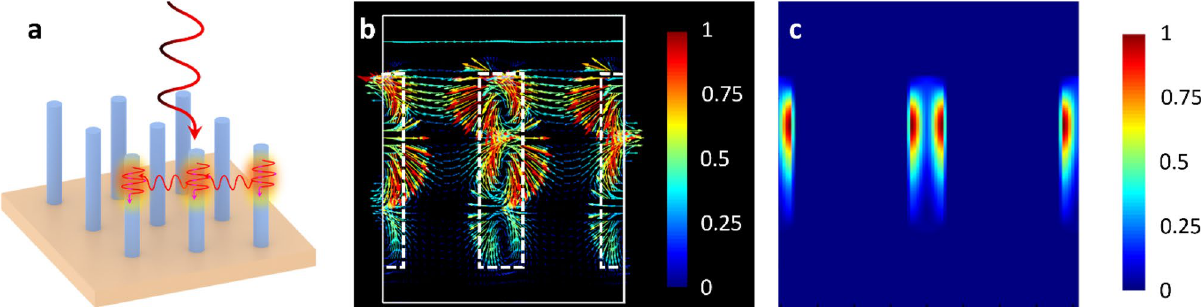
Figure 1. Mechanisms for enhanced absorption. ( a ) Schematic view of the collective interaction of a cylindrical nanowire metamaterial depicting the direct and indirect coupling to leaky guided and transverse modes. The leaky nature of the guided modes in the nanowires leads to free-space scattering of the electric field, which is then recoupled into the neighbouring nanowire metaatoms via excitation of TE and TM modes. ( b ) Simulated electric field response of a nanowire array with periodicity of 833 nm, nanowire diameter of 200 nm and height of 1400 nm. The interaction of the electric field between neighbouring nanowires is depicted by the vectors and their color indicates the field strength. ( c ) Localized absorption profile (indicated by the color) of the nanowire metamaterial at λ = 1020 nm with the same dimensions as ( b ). In the ( b , c ) color bars, red represents the maximum magnitude (normalized to 1) and blue is the